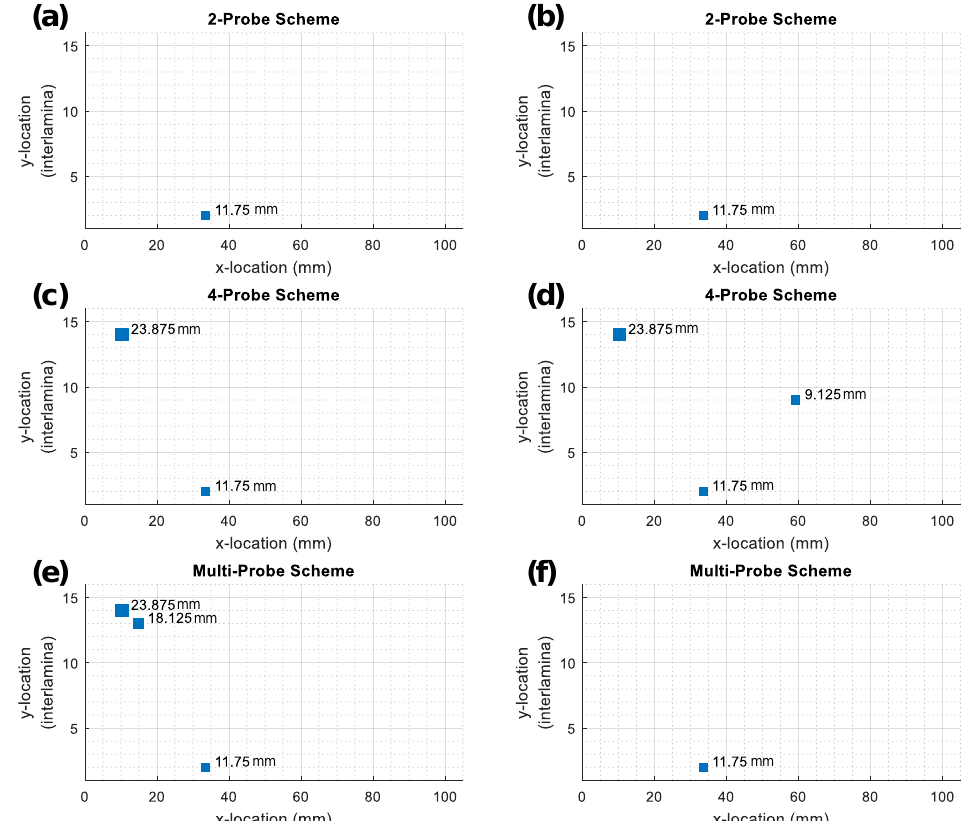
Figure 10. Failed damage cases for [( 0/90 ) 4 ] s with two-sided electrodes and: ( a ) two-probe scheme and full set of responses; ( b ) two-probe scheme and reduced set of responses; ( c ) four-probe scheme and full set of responses; ( d ) four-probe scheme and reduced set of responses; ( e ) multi-probe scheme and full set of responses; ( f ) multi-probe scheme and reduced set of responses. Crack size is shown next to the case